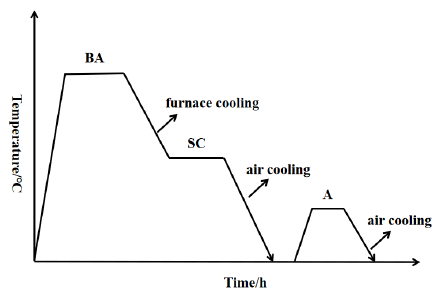
Figure 1. BASC and BASCA heat treatment diagram.